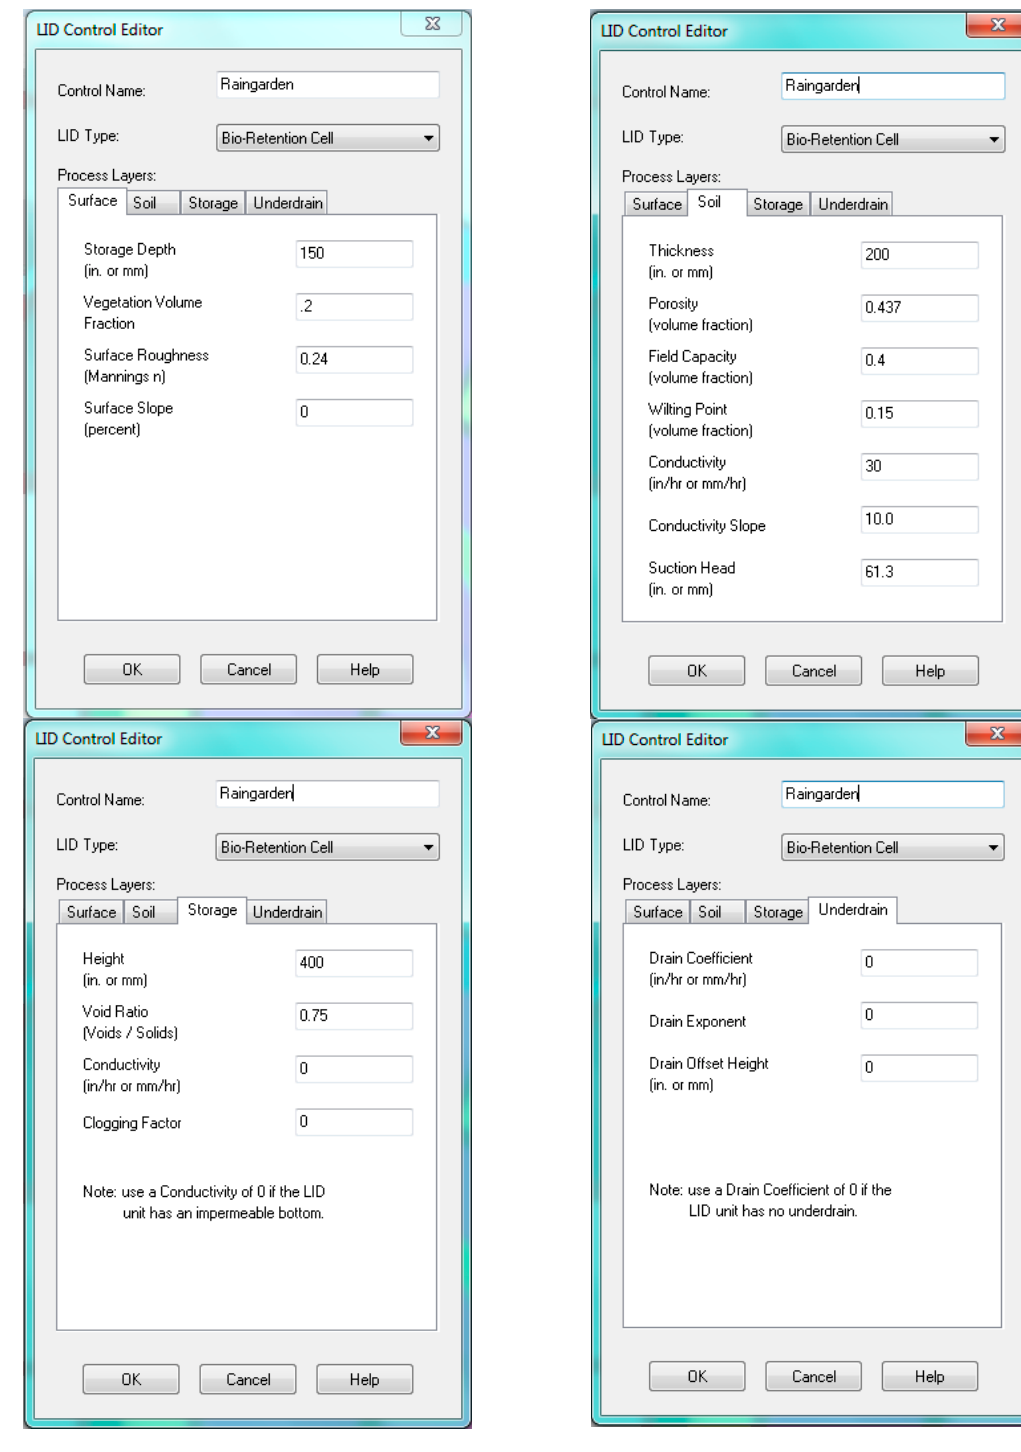
FigureA2. Representation of rain gardens in SWMM and design parameters used. Figure A2. Representation of rain gardens in SWMM and design parameters